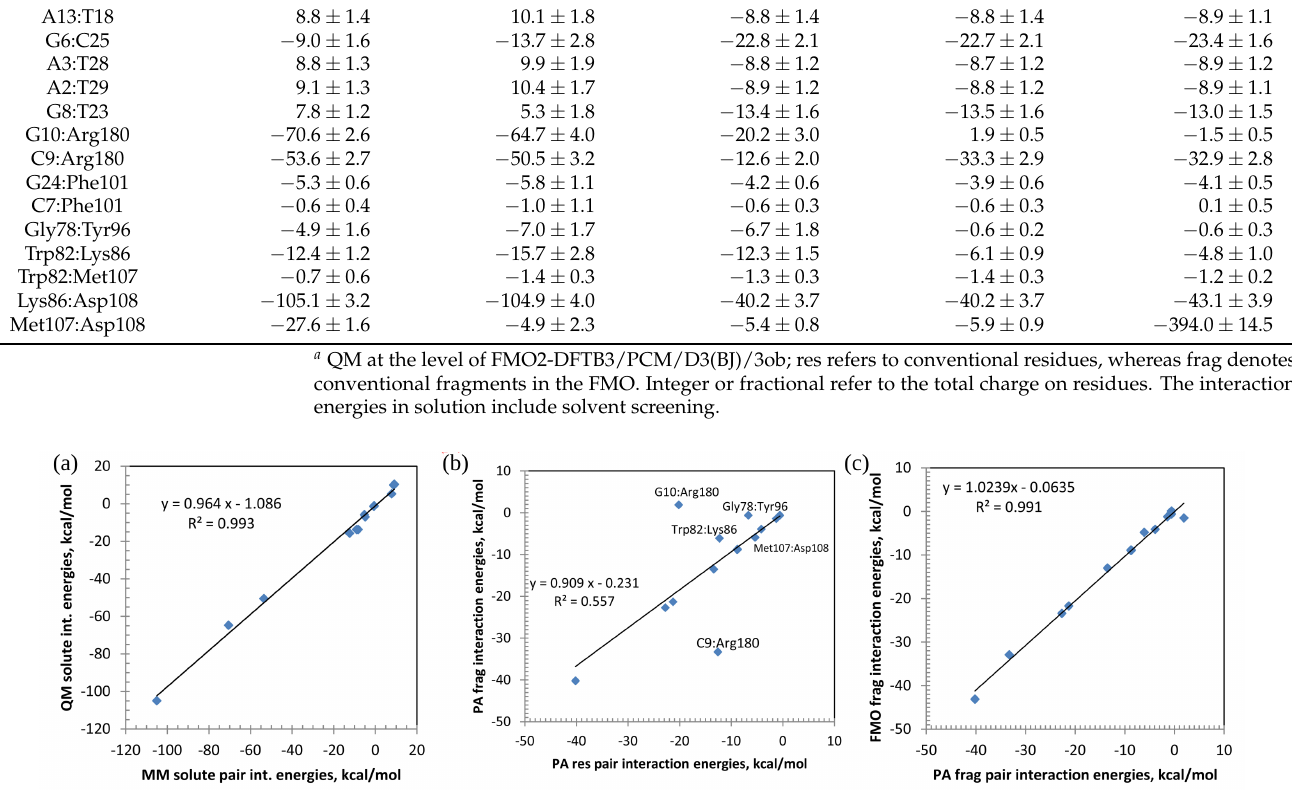
Figure 3. Correlation between pair interactions for conventional residues (res) and fragments (frag): ( a ) MM(solute,res) vs. QM(PA,solute,res), ( b ) PA(solution,res) vs. PA(solution,frag), and ( c ) PA(solution,frag) vs.